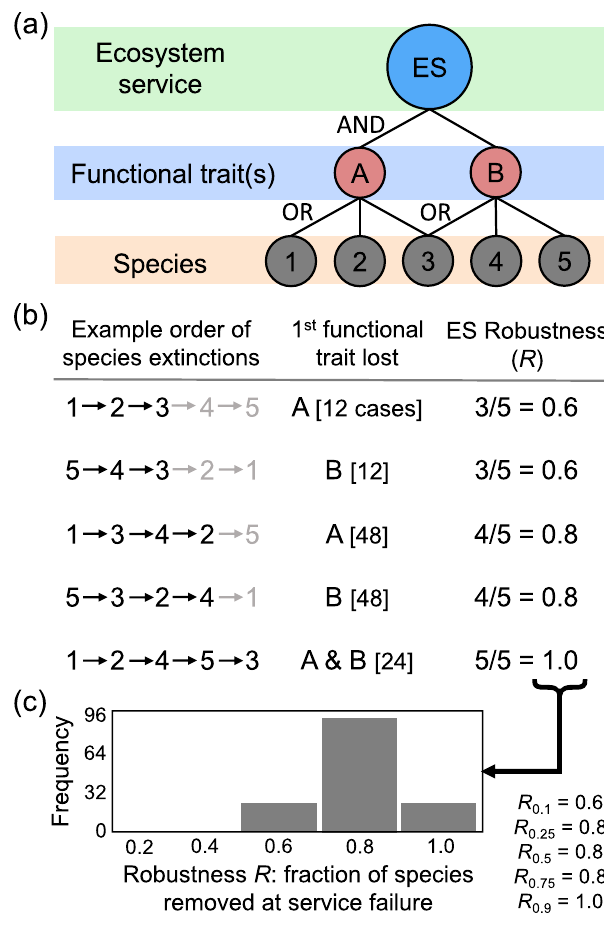
Fig. 1 The principles of our approach to measuring the robustness of ecosystem services to species loss. a We use a qualitative framework (see ‘ Methods ’ for a detailed description) whereby species [1 – 5 in this example] are linked to their functional traits [A and B] and are either present or absent from a community. An ecosystem service [ES] is supplied only when all underpinning functional traits are present in the community (the Boolean function AND; see ‘ Methods ’ and Supplementary Methods for justi fi cation). b As species are removed sequentially from the system, a functional trait is present until all species connected to that trait are lost. In this way, species losses are tolerated (the Boolean function OR) until a unique functional trait has been lost. ‘ Example order of species extinctions ’ presents illustrative examples of the sequential removal of the species in a , with sequences in grey indicating extinctions after service failure. ‘ 1 st functional trait lost ’ is the identity of the unique functional trait [A and/or B] fi rst lost from the system — which, under our framework, necessarily causes service loss — with [ n cases] indicating the number of extinction sequences for which this result is obtained [re fl ected also in the histogram ( c )]. We measure ‘ ES Robustness ( R ) ’ as the fraction of species removals required to bring about loss of a service for each extinction sequence. c This results in a distribution of robustness R values, representing the fraction of species loss tolerated across all extinction scenarios. This distribution of R values can be described via its percentiles [denoted with subscript c ] with, for example, the median robustness [ R 0.5 ] here equating to 0.8. That is, in 50% of extinction scenarios in this hypothetical example, 4/5 or fewer species extinctions are required to cause service